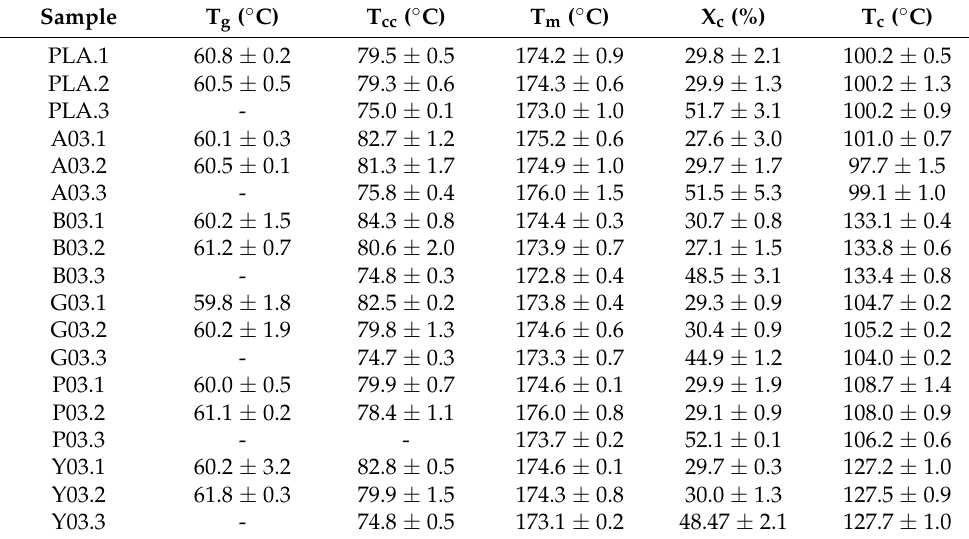
Figure 11. DSC thermogram of PLA and dyed yarns containing 0.3% ( w / w ) of each colorant at an SSD ratio of 3 during ( a ) the heating cycle and ( b ) the cooling cycle. Table 4. The thermal transition values of PLA and dyed yarns drawn at different SSD ratios with SD ( n = 3).